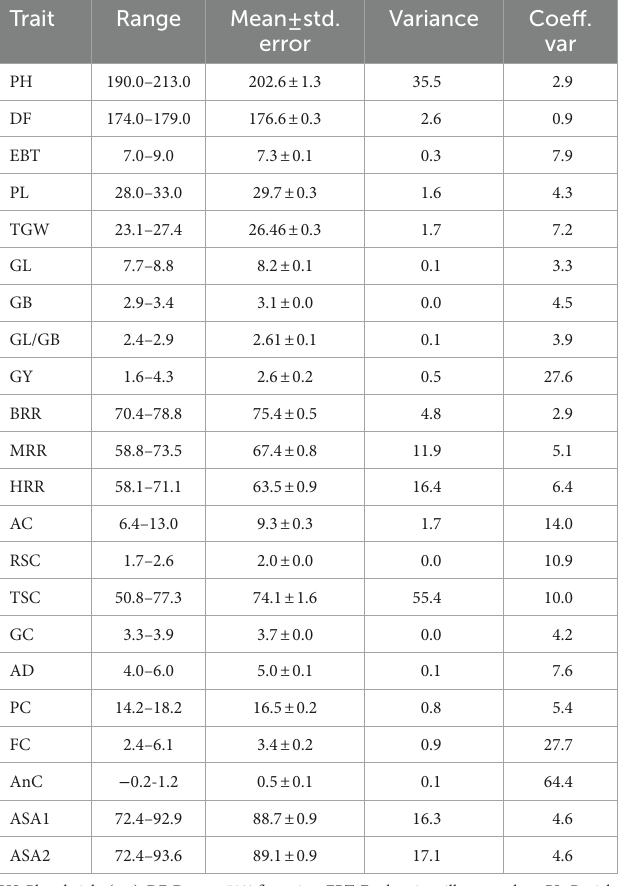
TABLE 2 Range and statistical parameters for agro-morphological and biochemical traits of C14-8 derived lines. Trait Range Mean ± std. Variance Coeff. error